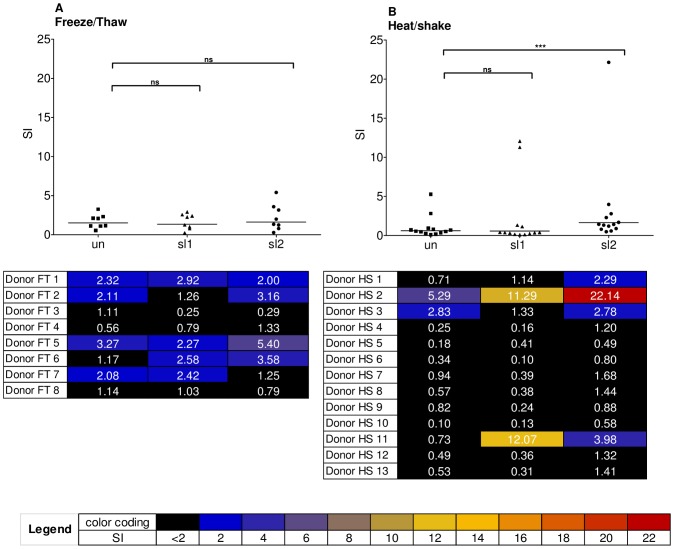
Results from T-cell activation assay.T-cell responses determined by IFN-γ ELISpot from donors treated with mAb1, un, sl1 and sl2 material from (A) FT condition (8 donors) and from (B) HS condition (13 donors). The respective heat maps specify to which extent each single donor responded to each treatment. The horizontal line shows the geometric mean of the populations. ***: statistically significant (p<0.001); ns: statistically not significant. HS: aggregates generated by heat and shake stress, FT: aggregates generated by freeze and thaw stress, mAb1: monoclonal antibody 1, SI: Stimulation index, un: unstressed, sl1: stress level 1, sl2: stress level 2.